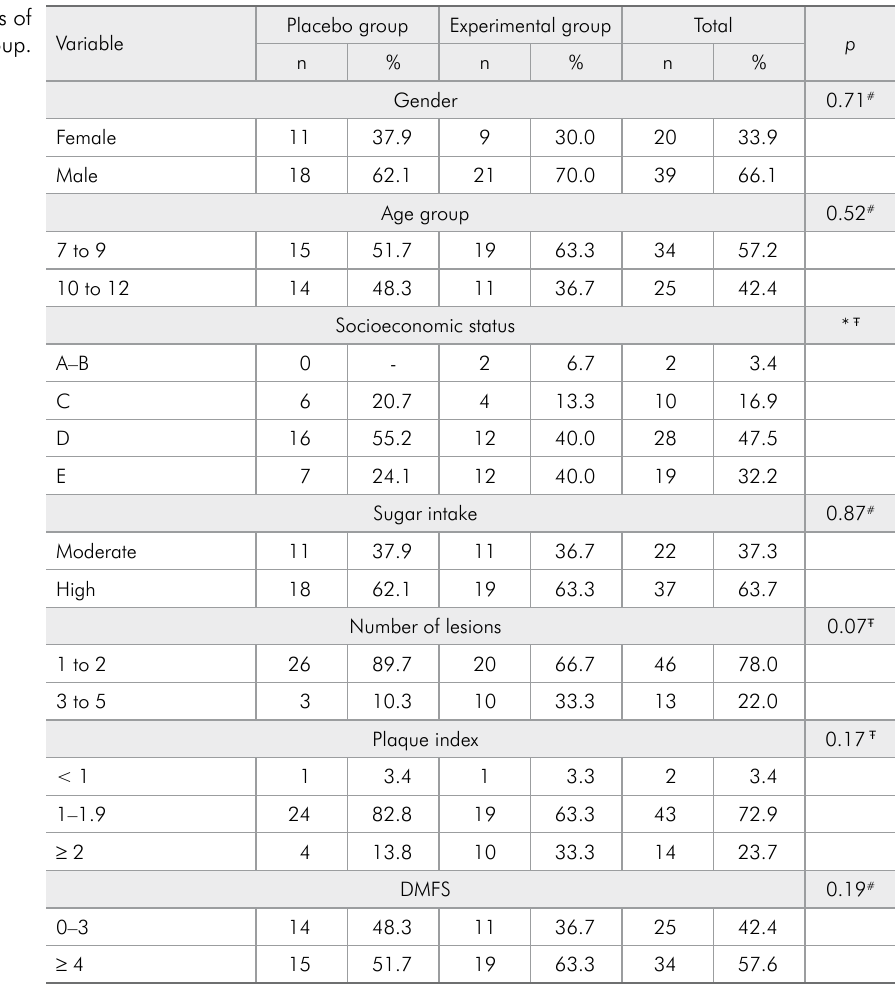
Table 1 - Characteristics of children by treatment group.